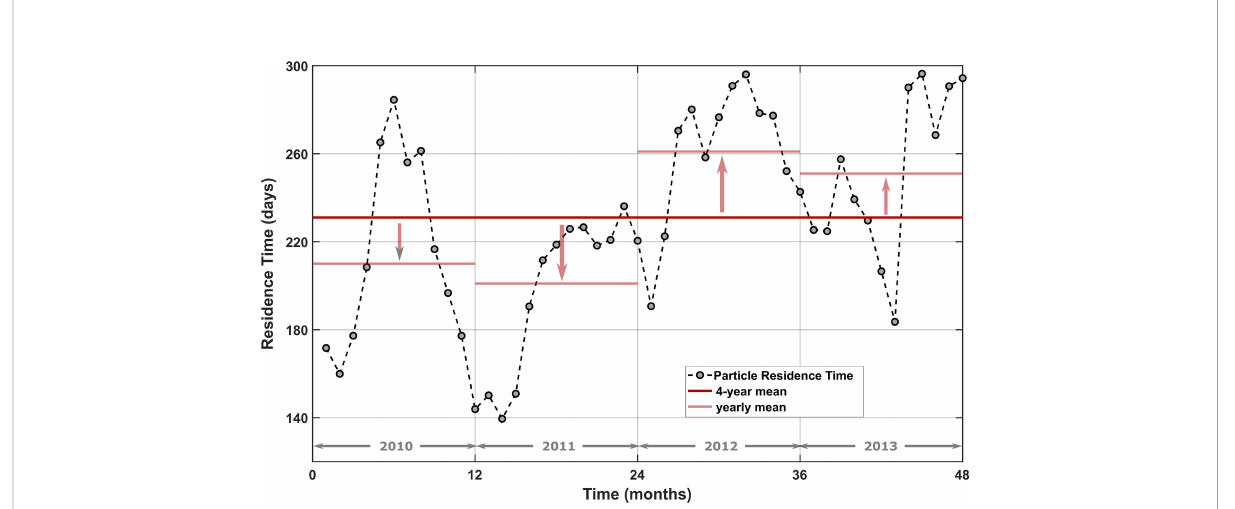
FIGURE 13 Residence time (days) of virtual particles in the eastern GoM as a function of deployment month. The solid red line shows the 4-year mean, whereas the light red lines show yearly means with arrows indicating offset from the 4-year